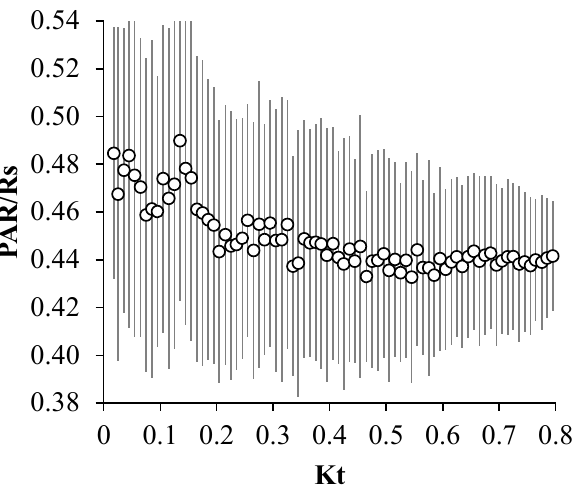
Figure 7. Averages and standard deviations of the PAR/Rs hourly ratio with the variation of the clearness index K t grouped in 0.01 bin-classes.